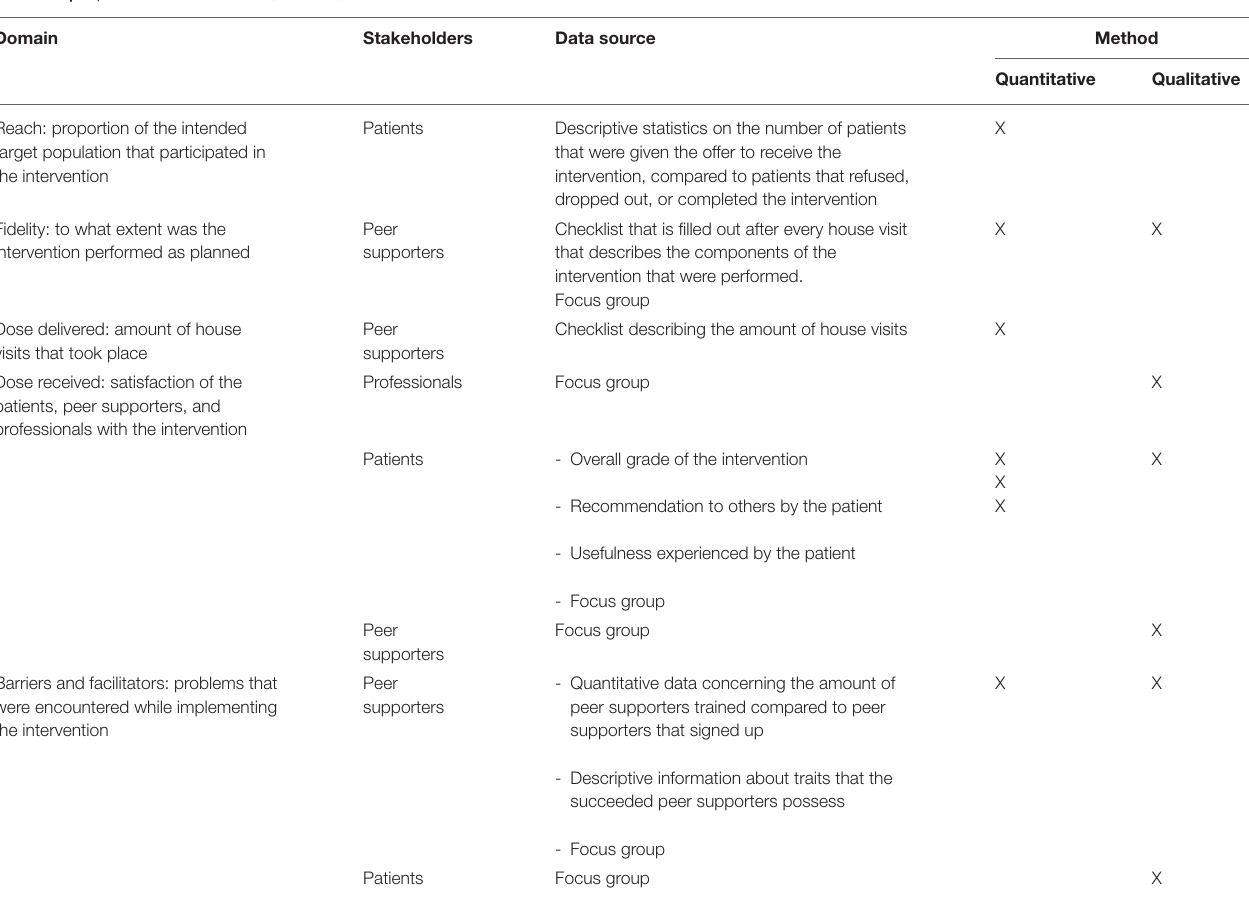
TABLE 3 | Implementation measures, barriers, and